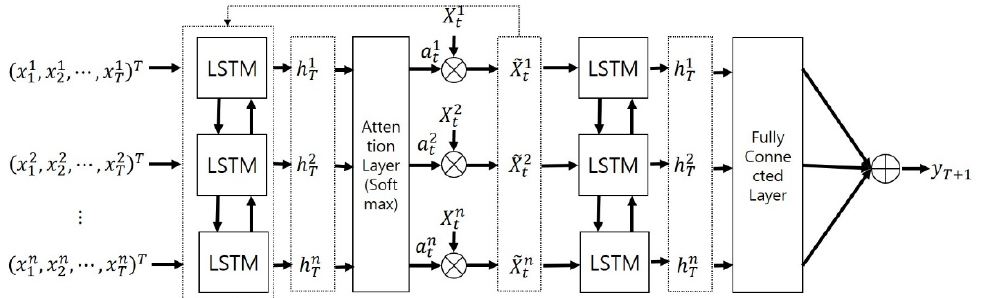
Figure 1. Structure of input attention-based Encoder network.